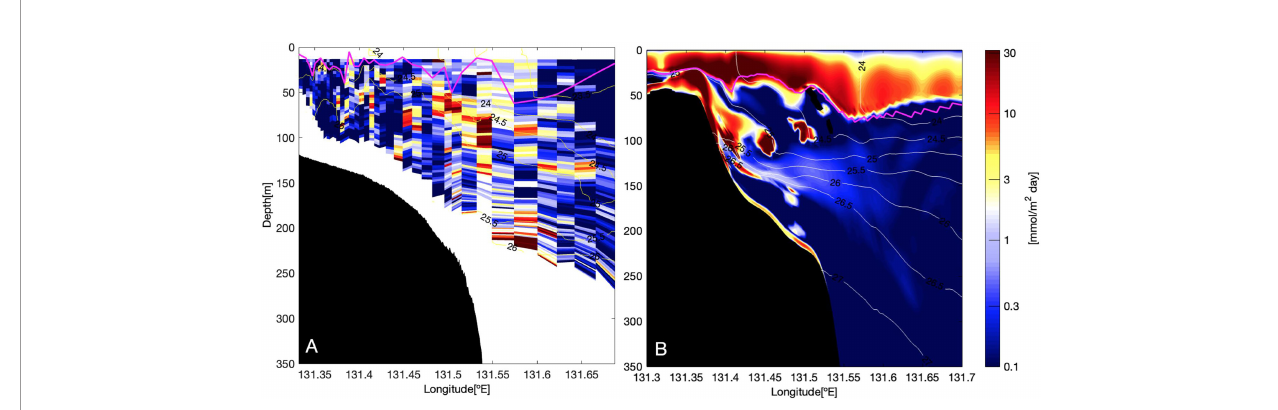
FIGURE 7 | Vertical sections of nitrate diffusive fl ux (mmol m -2 day -1 ) for (A) in-situ data in November 2018 (Nagai et al., 2019) and for (B) numerical simulation on December 20 th at hour 18:00. Magenta line represents the MLD.